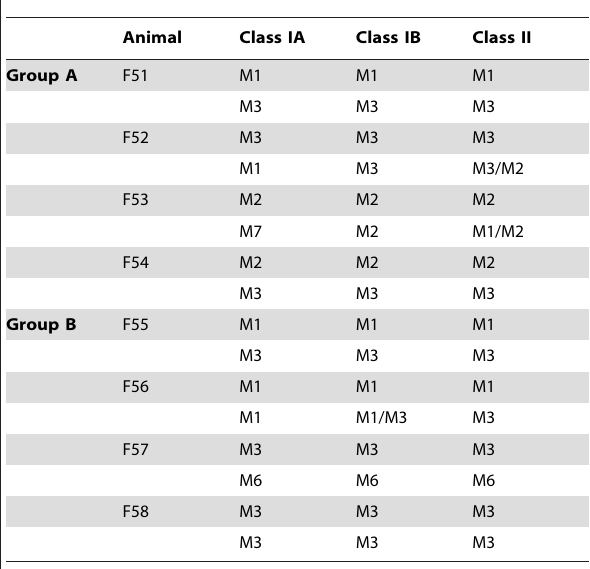
Table 1. Macaque MHC haplotype analysis.